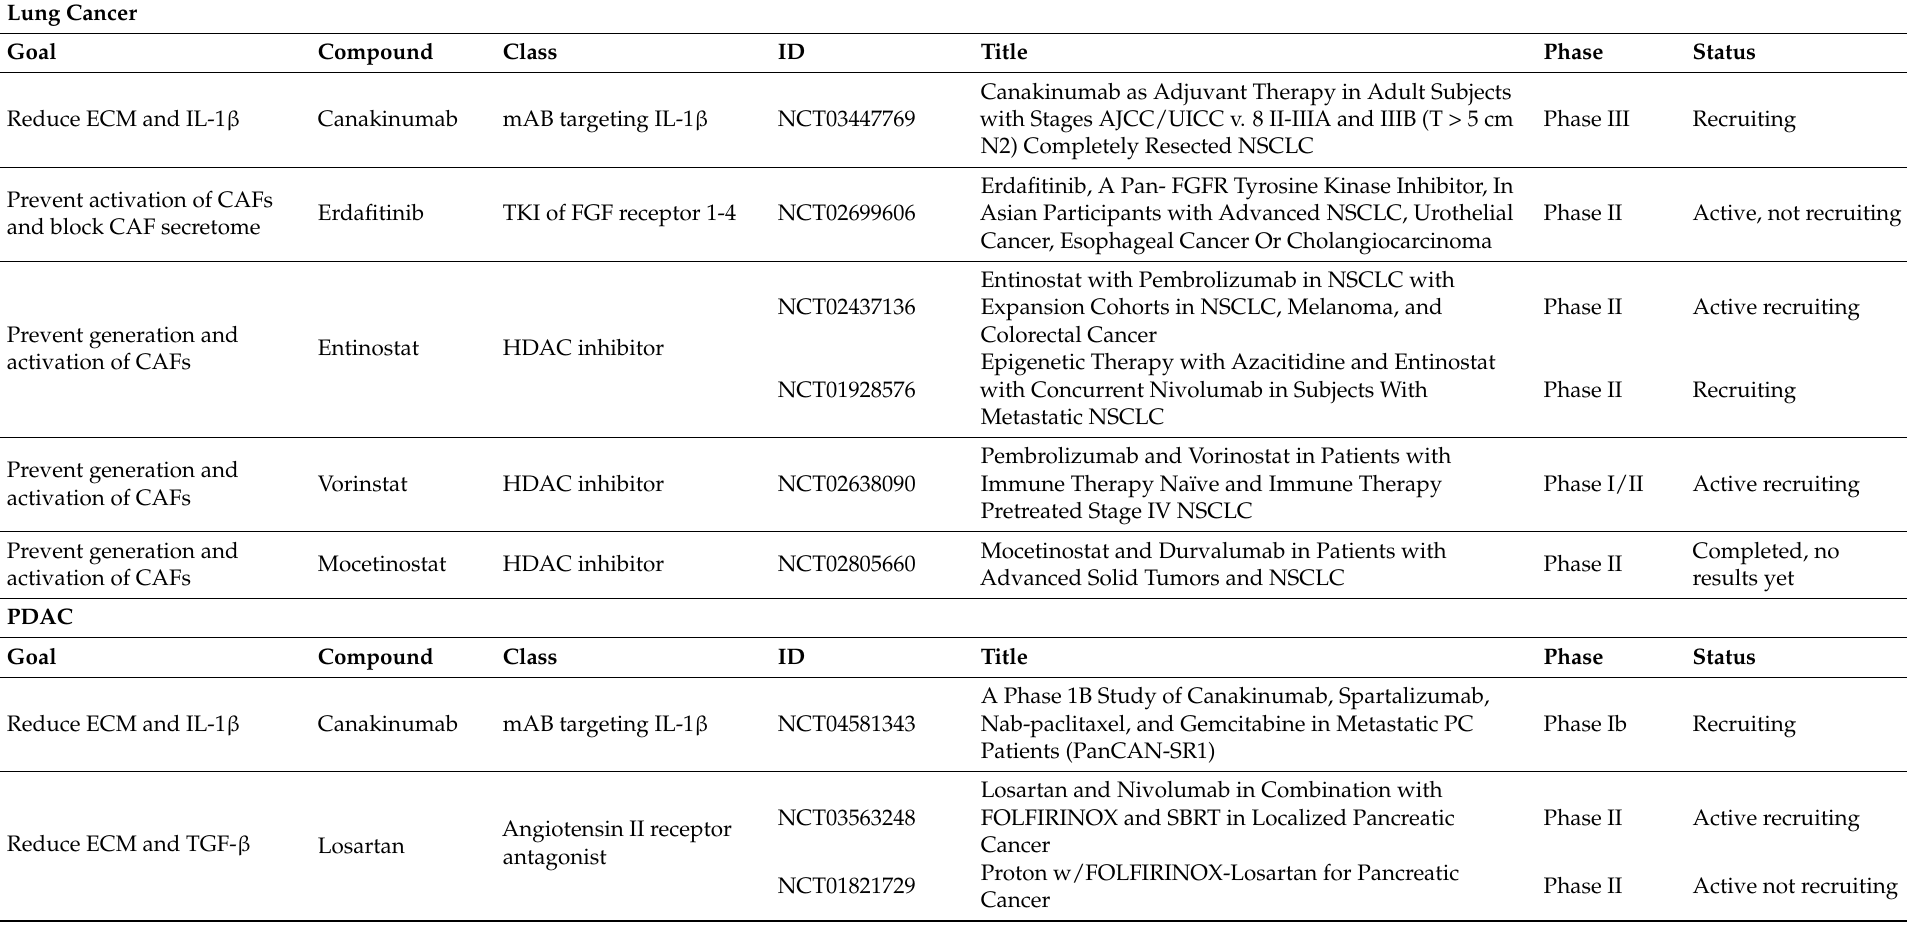
Table 1. Active clinical trials targeting CAF in lung cancer and